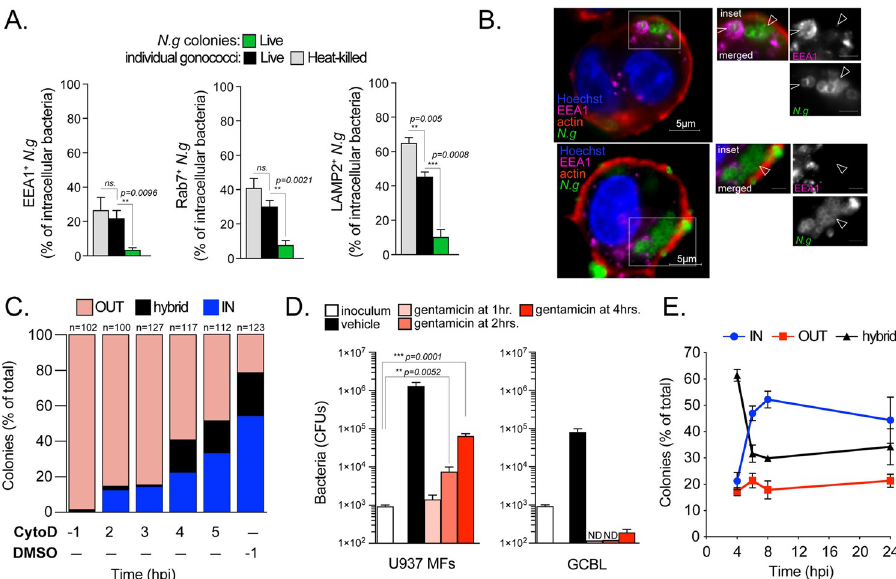
Fig 5. Trafficking and kinetics of intracellular colonization by gonococci. (A-B) Analysis of endosomal maturation of N . g FA1090-occupied phagosomes. (A) Recruitment of early (EEA1) and late endosomal (Rab7 and LAMP2) markers to phagosomes containing heat-killed or live individual gonococci at 2hpi and internalized gonococcal colonies at 6hpi. At least 100 bacteria or bacterial colonies were analyzed for each condition. (B) Representative single focal plane micrographs showing EEA1 accumulation on intracellular diplococci (arrowhead) and EEA1 exclusion from internalized gonococcal colonies (triangles). (C) Late entry facilitates intracellular colonization. Colony types distribution analysis of U937 MFs infected with N . g FA1090 at 8hpi when the actin polymerization inhibitor cytochalasin D (5 μ M) was added at the indicated time points to block bacterial internalization. Bacterial internalization is blocked even when cytochalasin D is added as late as 3hpi. (D) N . g survives intracellularly in U937 MFs upon late gentamicin treatment. Bacterial CFUs recovered at 8hrs following a gentamicin protection assay in infected U937 MFs or in liquid culture (GCBL) are shown. Gentamicin (4 μ g/ml) was added at the indicated time- points. (E) Kinetic analysis of colony types in U937 MFs infections (MOI = 2) with N . g FA1090. At least 80 colonies for each condition were scored. (A, D and E) Means of technical triplicates ± SD are shown, unpaired T-test, not significant (ns.). (A-E) Representative experiments from two (C) or at least three (A-B, D-E) biological replicates are